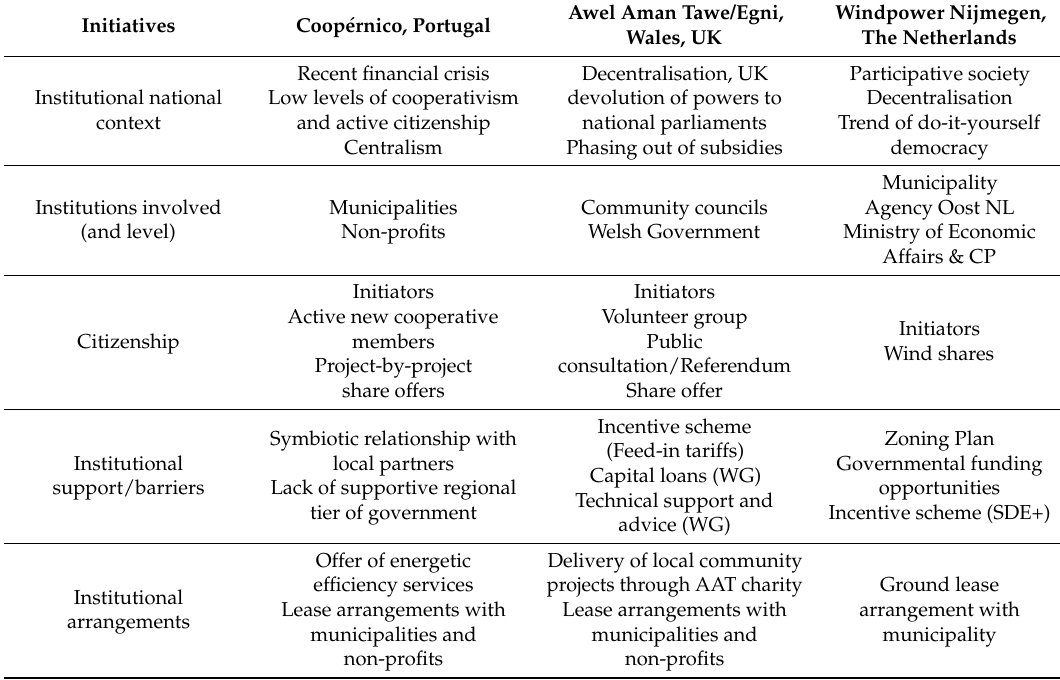
Table 1. Summary of main features of the three initiatives in terms of existing institutional framework, support, and